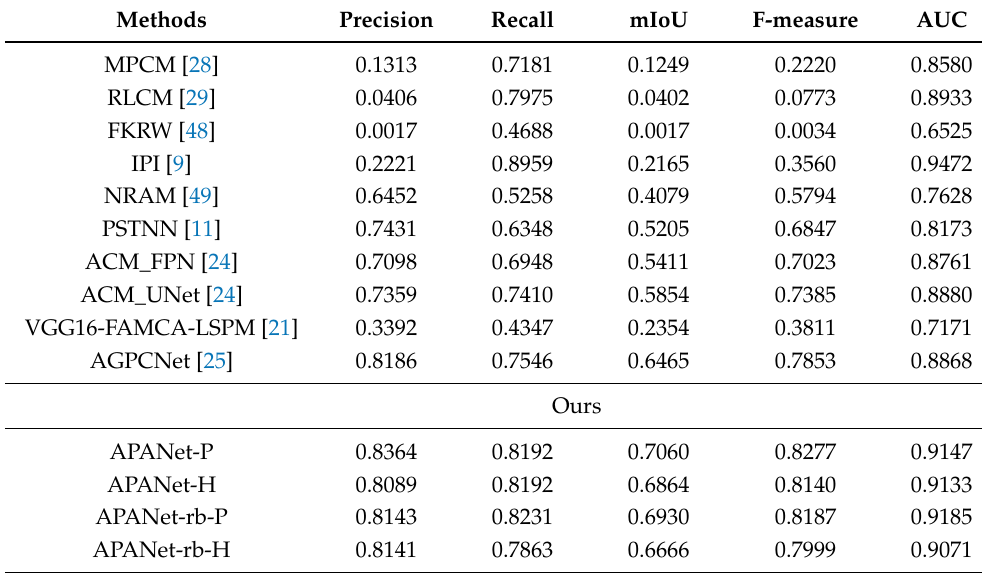
Table 3. Comparison with different detection methods on SIRST